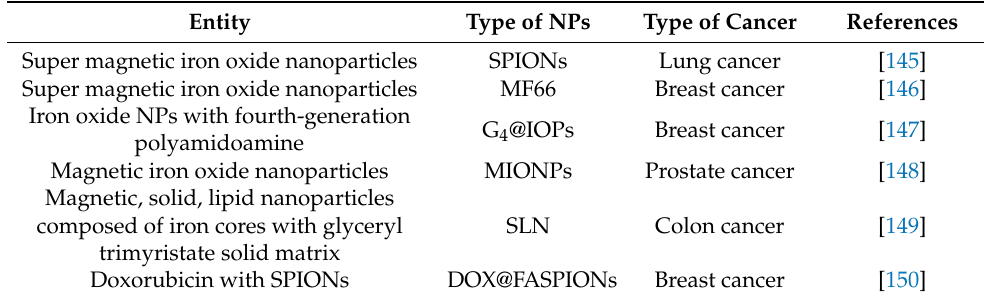
Table 9. Types of magnetic nanoparticles and their applications in cancer therapy.